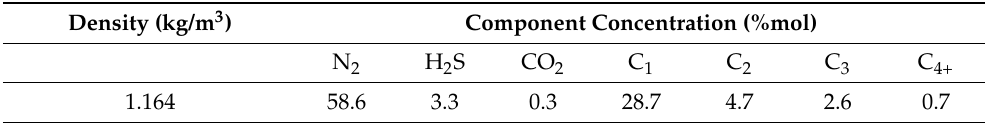
Table 4. Simplified composition of MG natural